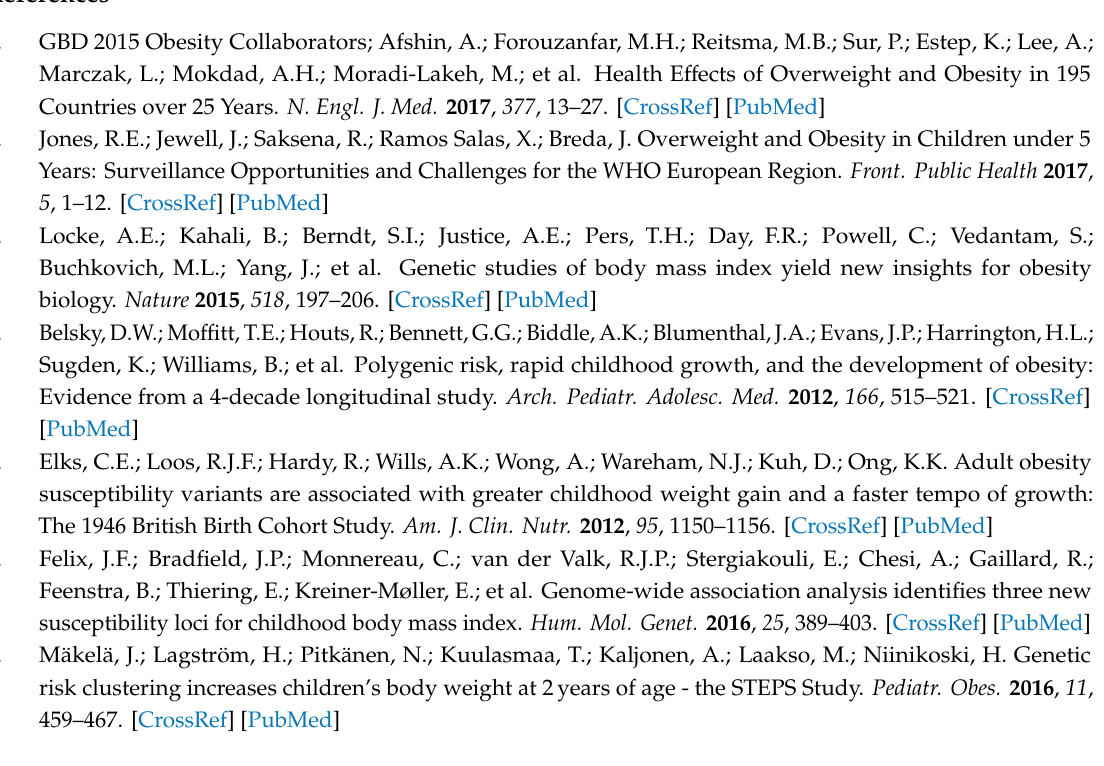
Figure S2: Bar plot showing the number of normal weight, overweight and children with obesity according to each quartile of the pGRS in the study population 1, Figure S3: Stepwise linear regression including all 44 tested SNPs in order to know which of them contribute the most to the pGRS-BMI association, Table S1: General characteristics, anthropometry, biochemical parameters, adipokines and cardiovascular / proinflammatory biomarkers in the cross-sectional cohort of 574 children (study population 1), Table S2: Descriptive statistics for the longitudinal study population 2, Table S3: Clinical characteristics of the study population 3 at baseline and post-treatment stages, Table S4: Hardy-Weinberg Equilibrium test for all analyzed genetic variants in study population 1, Table S5: List of 44 SNPs passing quality control filters and finally included in the Genetic Risk Score, Table S6: Lifestyle factors assessed in our study for the study population 1, Table S7: Individual single-SNP analyses on BMI Z-Score in the study population 1, Table S8: Association between the pGRS (quartilized) and the metabolic health status of children in the study population